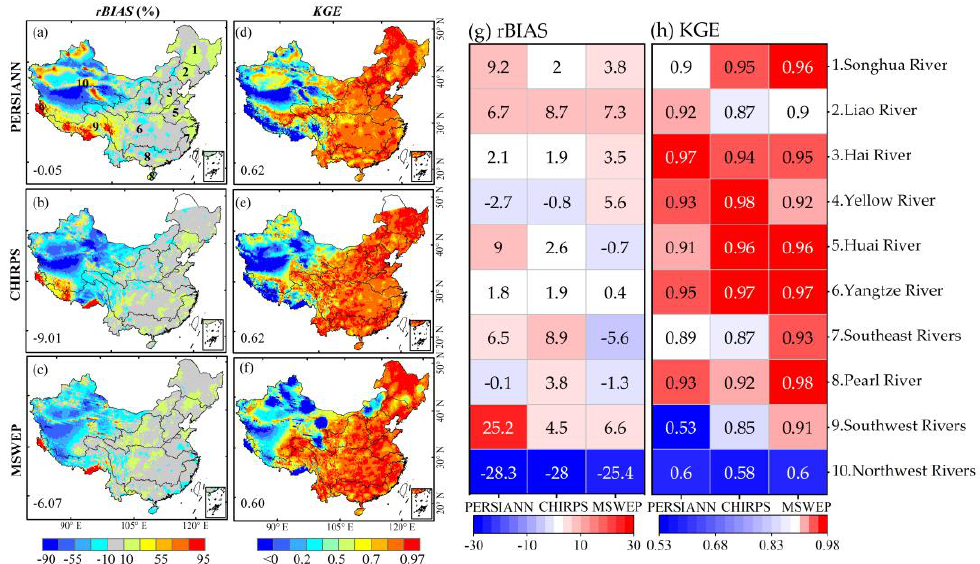
Figure 6. Spatial distribution (a-f) and basic statistical information (g-h) of the three RSPEs over the 10 first-level river basins of China. The numbers in (a) indicate : 1-the Song Hua River, 2-the Liao River, 3-the Hai River, 4-the Yellow River, 5-the Huai River, 6-the Yangtze River, 7-southeastern rivers, 8-the Pearl River, 9-southwestern rivers, 10-northwestern rivers.